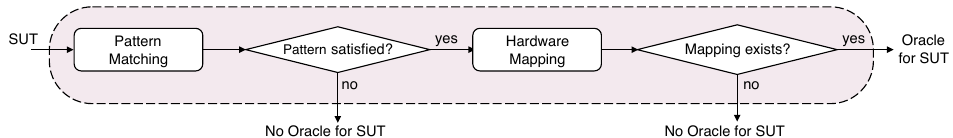
Figure 7. The oracle generation